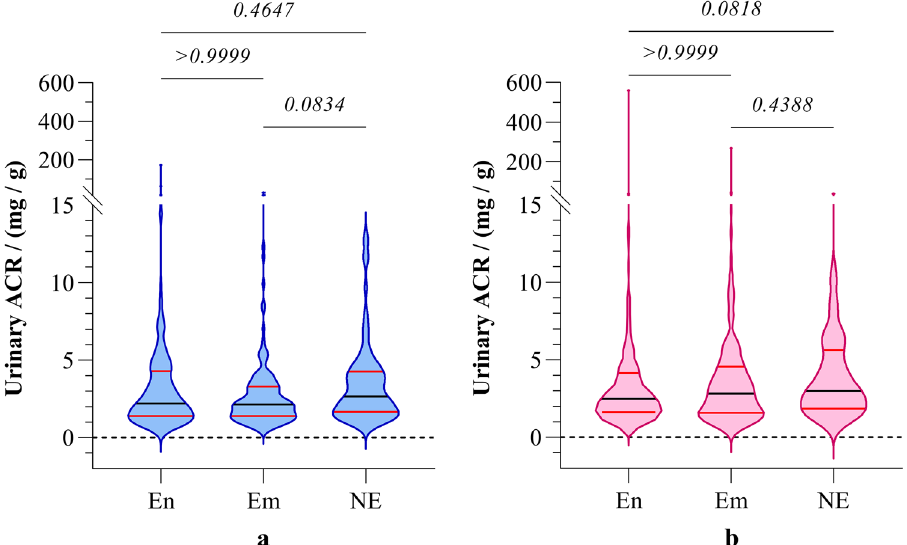
Figure 6. Gender stratified distribution of urinary ACR in ( a ) boys and ( b ) girls from CKDu endemic, emerging, and non-endemic regions. Graphs illustrate the median and interquartile range. Inter-group comparison is expressed in terms of Kruskal–Wallis one-way analysis followed by Dunn’s multiple comparison test. The study groups: En: endemic, Em: emerging, and NE: non-endemic regions. ACR: albumin to creatinine